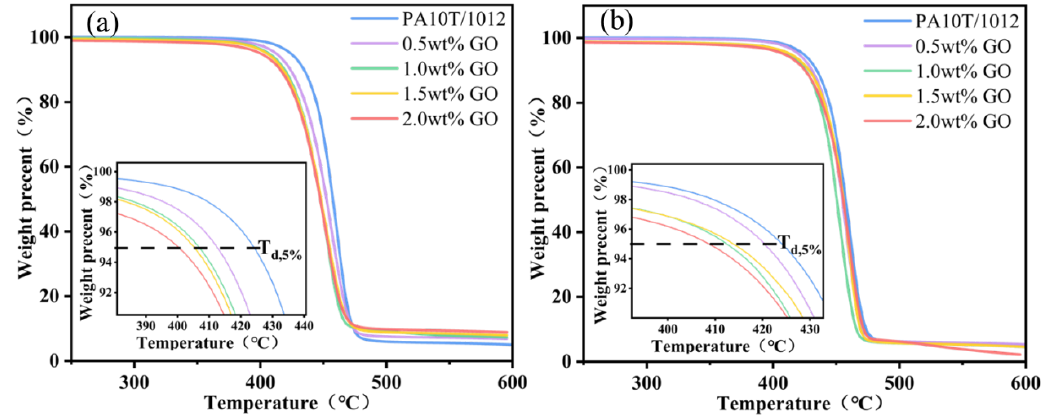
Figure 10. Thermogravimetric (TG) curves: ( a ) SPA composites; ( b ) MPA composites.